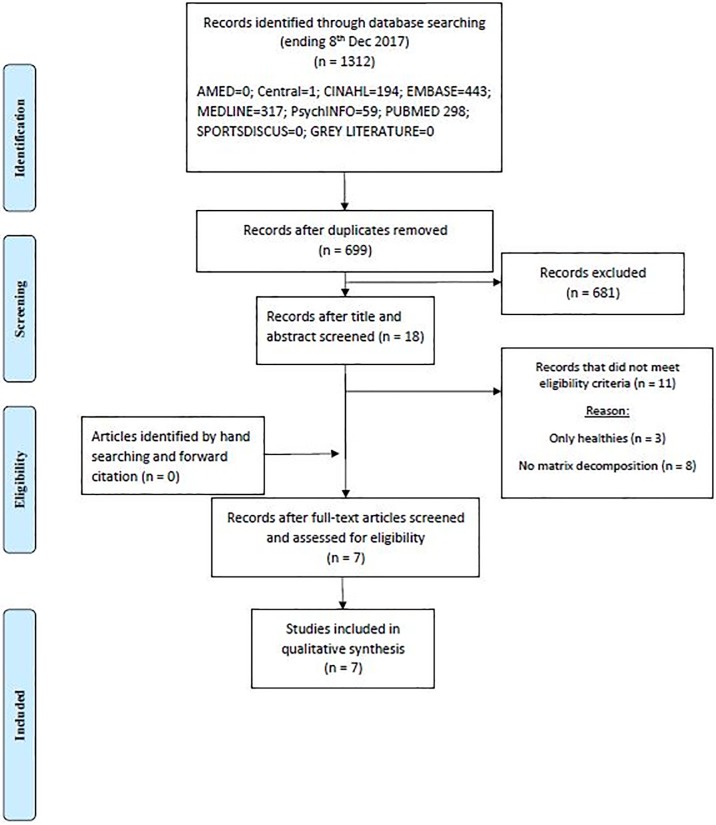
PRISMA flowchart.